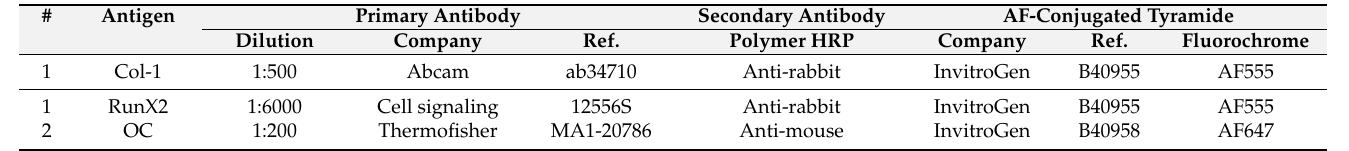
Table 1. Combination of primary and secondary antibodies, and AlexaFluor-conjugated tyramides for multiplex immunofluorescence